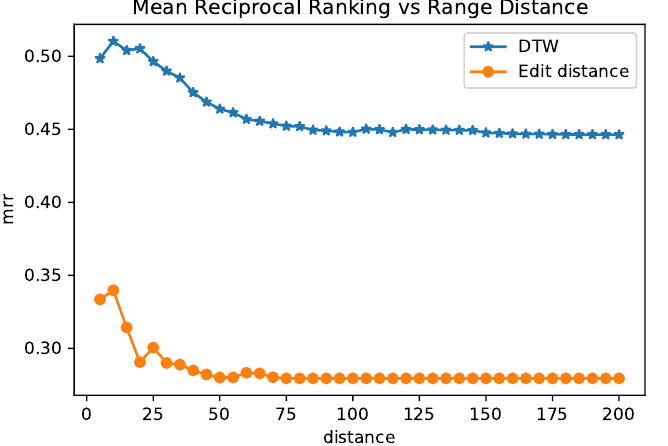
Figure 10. Mean reciprocal rank of the embeddings among trajectories pairs under a maximal